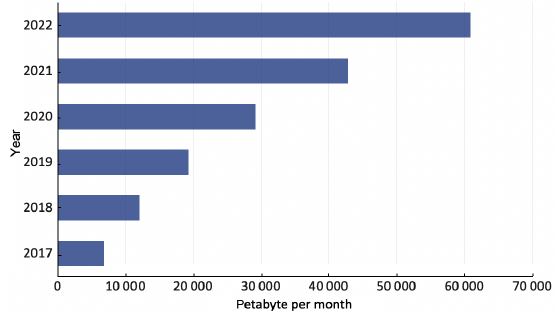
Fig. 8 Global mobile video traffic from 2017 to 2022 [120]